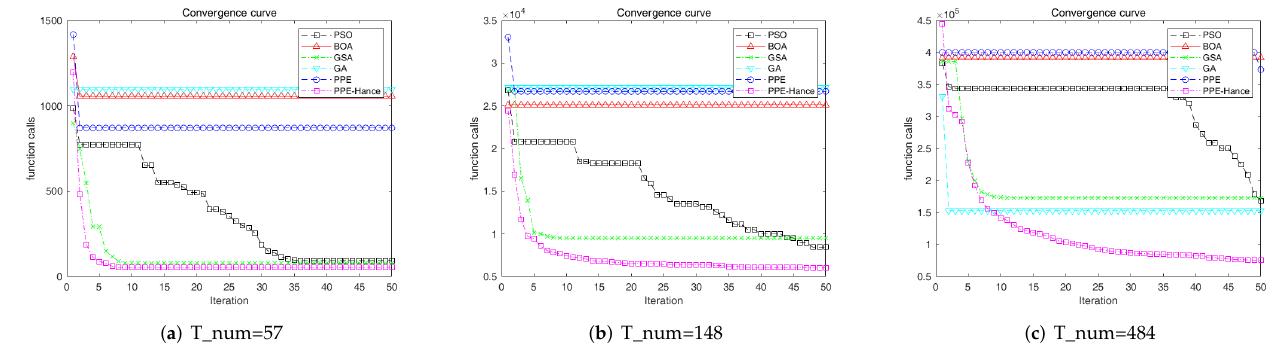
Figure 4. The convergence comparison of different numbers of tasks in heterogeneous Environment 2